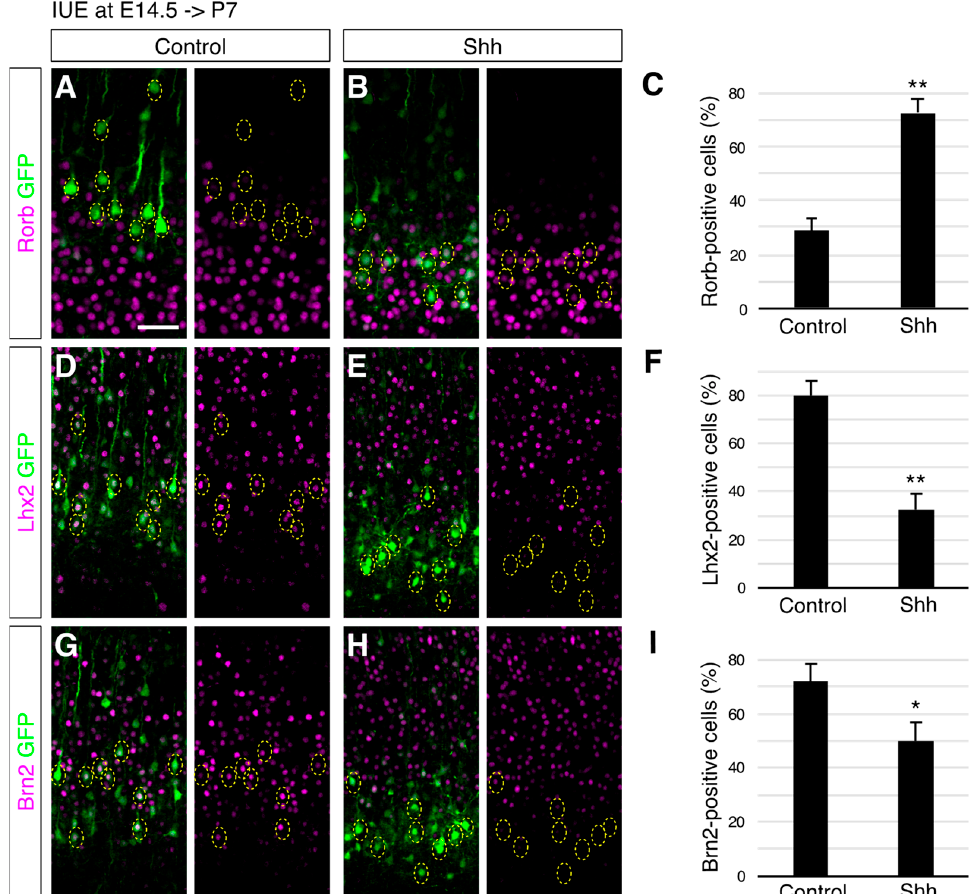
Figure 2. Shh-overexpressing cells at E14.5 acquire L4 characteristics. Empty (Control) or Shh expression vector (Shh) together with a GFP vector was electroporated into E14.5 brains, and then P7 brains were analyzed. The sections were immunostained for Rorb ( A , B ), Lhx2 ( D , E ), and Brn2 ( G , H ). The results of quantitative analysis for Rorb ( C ), Lhx2 ( F ), and Brn2 ( I ) are presented ( n = 3 for each group). ** p < 0.01, * p < 0.05. Note that Shh-overexpressing cells acquired expression of Rorb, but lost expression of Lhx2 and Brn2. (Scale bar: 200 µm in ( A )).